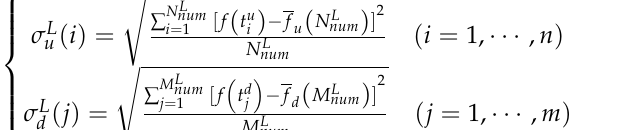
Figure 2. Diagram of adaptive waveform extraction from the raw waveform. An adaptive extraction method based on the cumulative standard deviation of the peak was used. Here, the time series of the maximum and minimum local amplitudes were obtained. The positive-direction local maximum sequence was represented by a time response amplitude function, 𝑓(cid:4666)𝑡 (cid:3036)(cid:3048) (cid:4667) , in which 𝑡 (cid:3036)(cid:3048) is the temporal position sequence and i represents the number of local maxima. The positive-direction local minimum sequence is described by 𝑓(cid:4666)𝑡 (cid:3037)(cid:3031) (cid:4667) , where 𝑡 (cid:3037)(cid:3031) and j are the temporal position sequence and number of local minima. Correspondingly, the cumulative standard deviation sequences of the pos- itive-direction maximum and minimum sequences, 𝜎 (cid:3048)(cid:3013) (cid:4666)𝑖(cid:4667) and 𝜎 (cid:3031)(cid:3013) (cid:4666)𝑗(cid:4667) , are expressed by Equation (2):